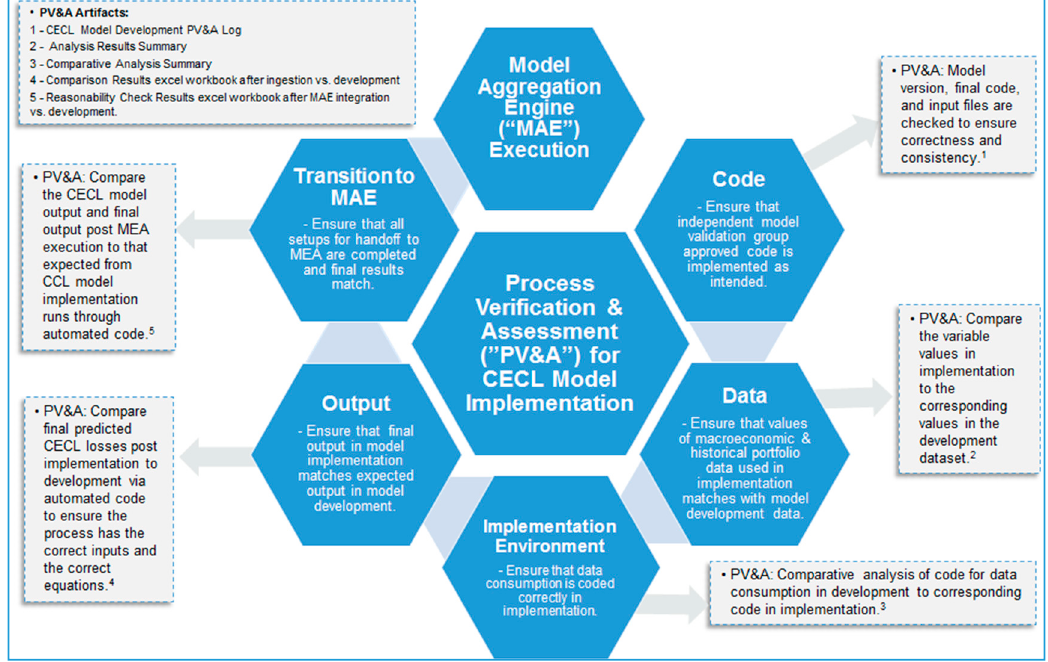
Figure 4. Framework for process verification and assessment of CECL model implementation and execution.